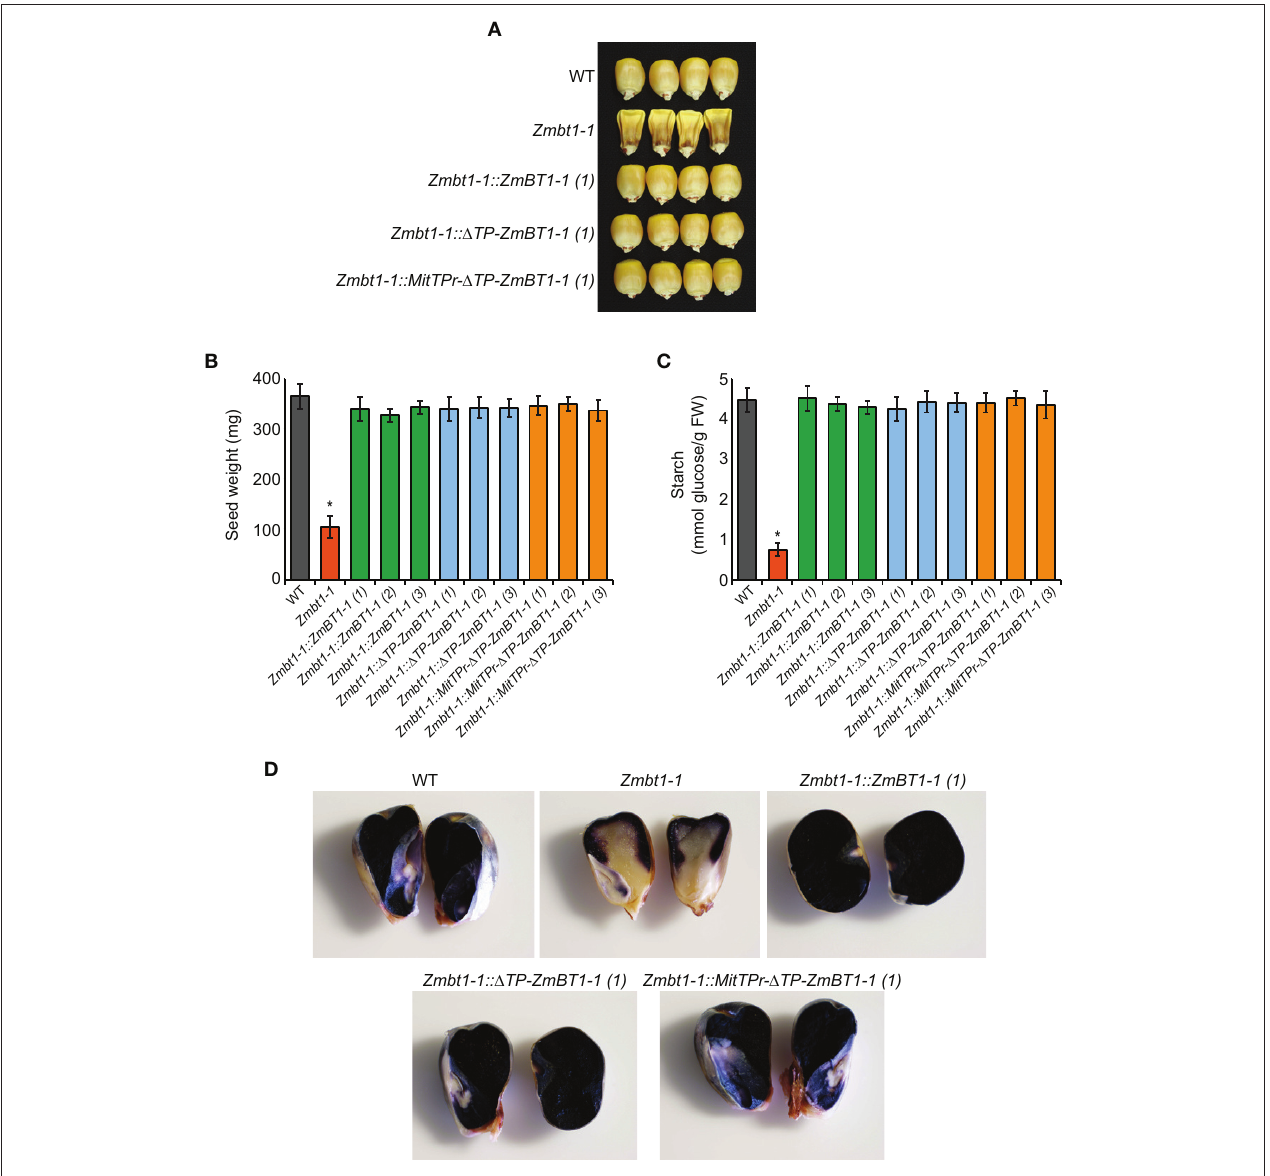
FIGURE 2 | Delivery of ZmBT1-1 specifically to mitochondria complements the collapsed angular appearance and the low endosperm starch content of Zmbt1-1 seeds. External appearance (A) , weight (B) , and starch content (C) of WT, Zmbt1-1, Zmbt1-1::ZmBT1-1, Zmbt1-1:: 1 TP-ZmBT1-1,